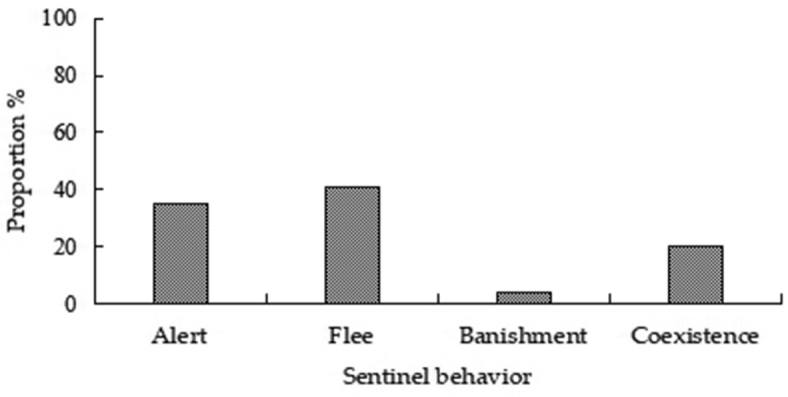
Proportion of sentinel behaviors of A.
peninsulae.